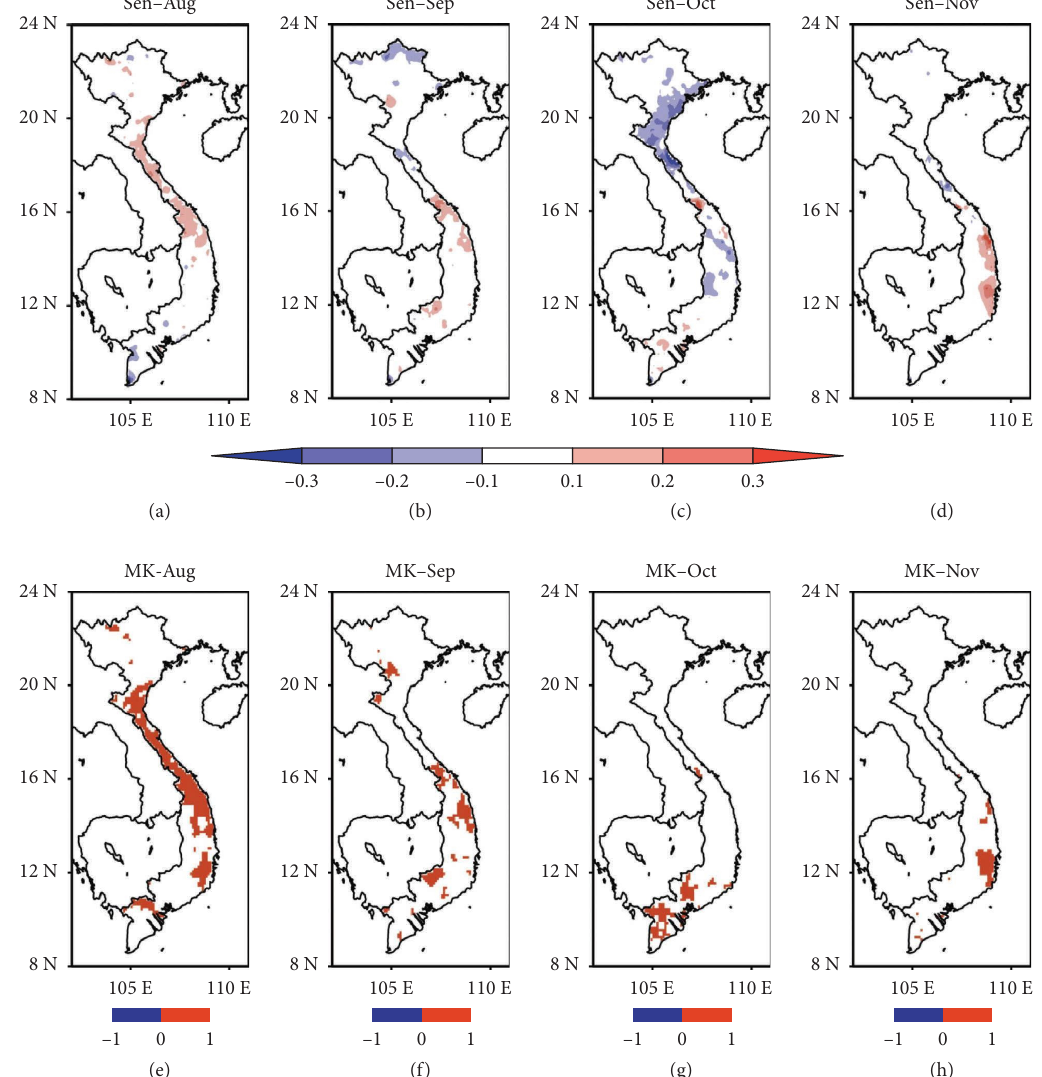
Figure 4: Sen’s trends for the fall rainfall in Vietnam in the period of 1981–2010 (a–d) and the grid points satisfying signifcant statistic at the 90% level using the Mann-Kendall test (e–h). (a) Sen-Aug. (b) Sen-Sep. (c) Sen-Oct. (d) Sen-Nov. (e) MK-Aug. (f) MK-Sep. (g) MK-Oct. (h)